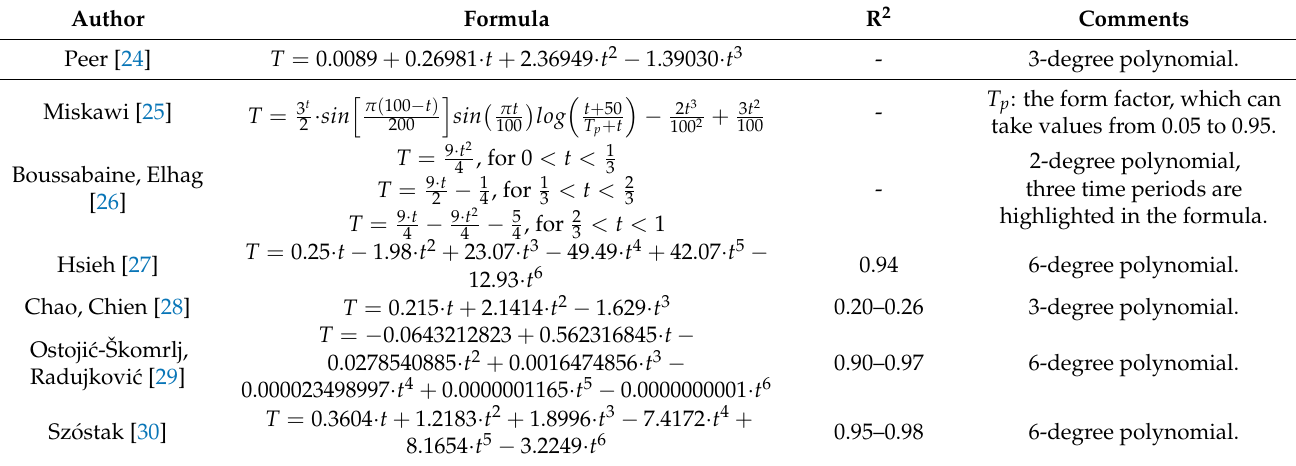
Table 1. Selected mathematical formulas describing the shape of the cost curve.